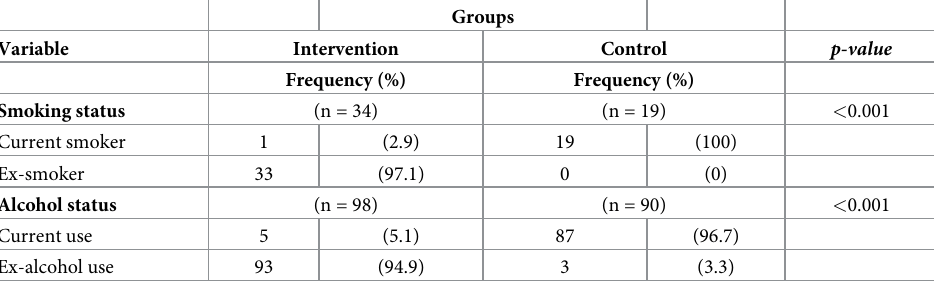
Table 4. Comparison of smoking and alcohol statuses of intervention and control groups at six months post intervention.